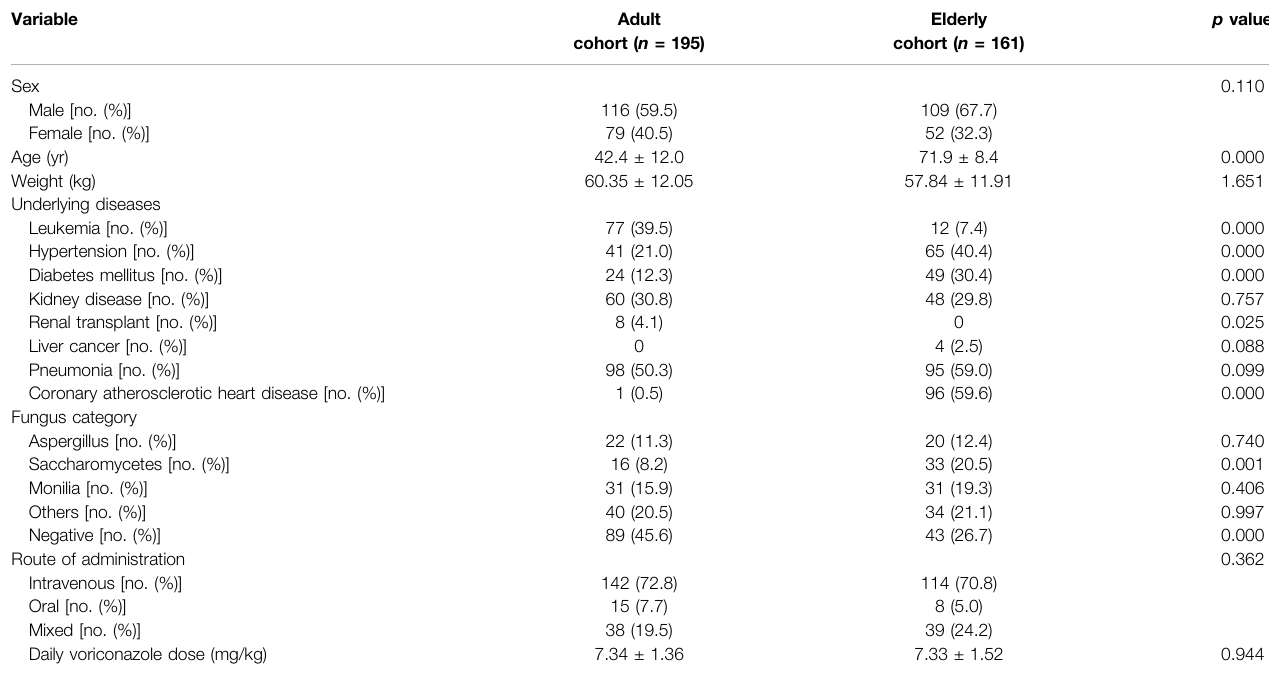
TABLE 1 | Baseline characteristics of patients in the two